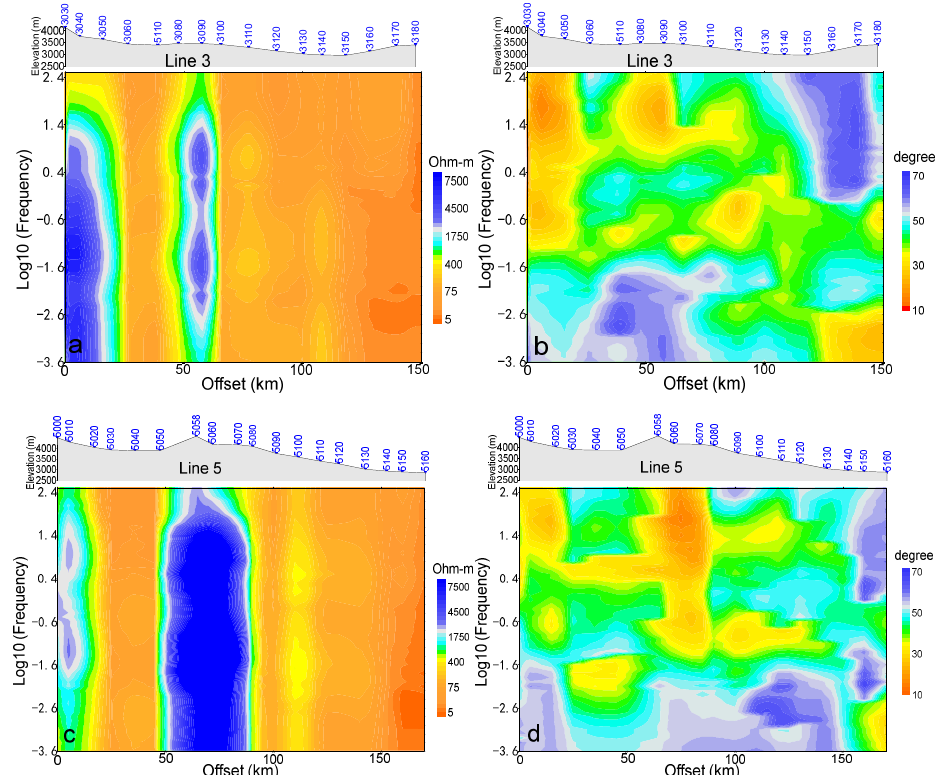
Figure A2. Pseudosections of apparent resistivity ( a , c ) and phase ( b , d ) versus frequency for Line 3 and Line 5.